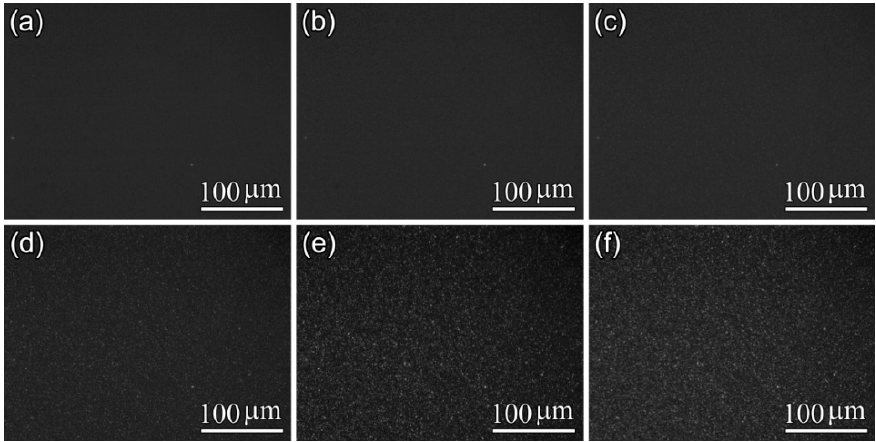
Figure 6. POM micrographs of PLA-T0 film during isothermal crystallization at 110 °C: ( a ) 0 min; ( b ) 6 min; ( c ) 9 min; ( d ) 13 min; ( e ) 20 min; and ( f ) 30 min.